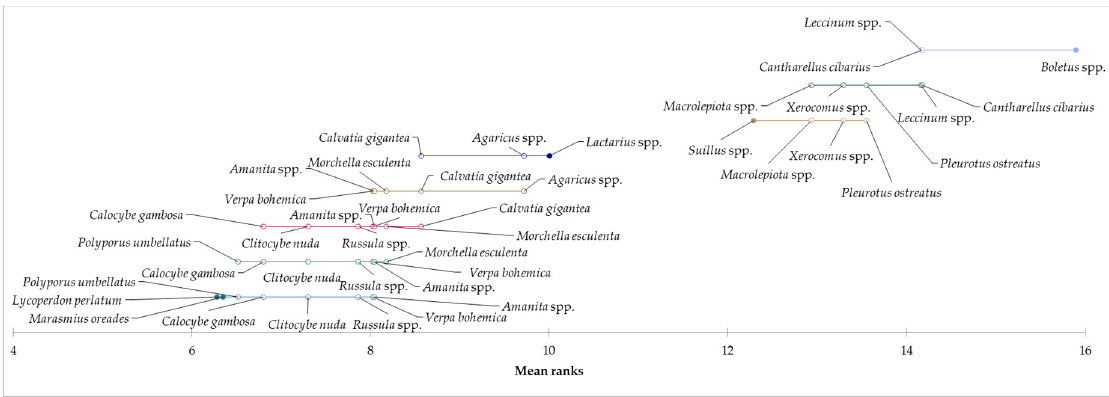
Figure 2. Differencesintheevaluationofpreferredspeciesofmushroomsinthe“regularconsumers”segment.